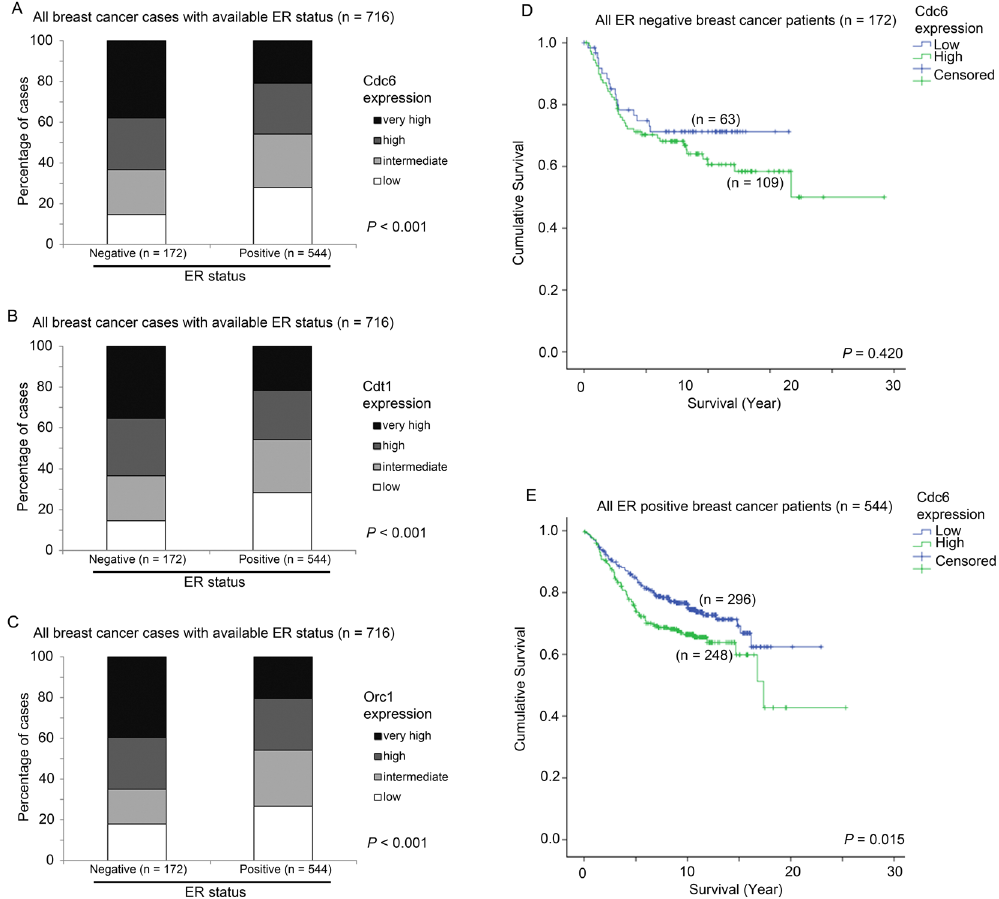
Figure 4. The association between expression of Cdc6, Cdt1 and Orc1 with different ER status and survival. Histograms showing the percentage of patients with various expression levels of ( A ) Cdc6, ( B ) Cdt1 and ( C ) Orc1 in patients stratified by ER status. Kaplan-Meier curves showing survival time of patients who express different levels of Cdc6 in patients with ( D ) ER-negative breast cancer and ( E ) ER-positive breast